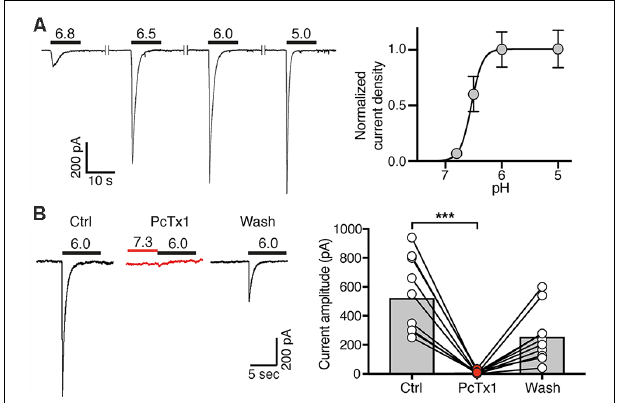
FIGURE 3 | Concentration-response curve and PcTx1 sensitivity of ASICs in post-mitotic LUHMES cells. (A) Cells were cultivated in differentiation medium for 6 days and were then analyzed by whole cell patch-clamp in voltage clamp mode. Left, representative ASIC currents elicited by transient pH changes from pH 7.4 to values between 6.8 and 5.0 for 10 s. For recovery of ASICs, cells were washed with a solution of pH 7.4 for 30 s. Right, concentration response curve. Currents were normalized to the current at pH 5.0, which had a density of 120 pA/pF. Line represents a fit to the Hill function. n = 11 cells from two independent experiments. (B) PcTx1 sensitivity of ASICs on d4–d8. Left, representative whole cell current traces, each elicited by a 10 s-pulse of pH 6 from conditioning pH 7.3. Traces were acquired before, during and after application of 30 nM PcTx1 for 2 min. Right, summary of peak current amplitude before, during and after PcTx1 application. n = 10. *** p = 0.0001 (paired t -test). surge in ASIC current. Nearly complete inhibition of